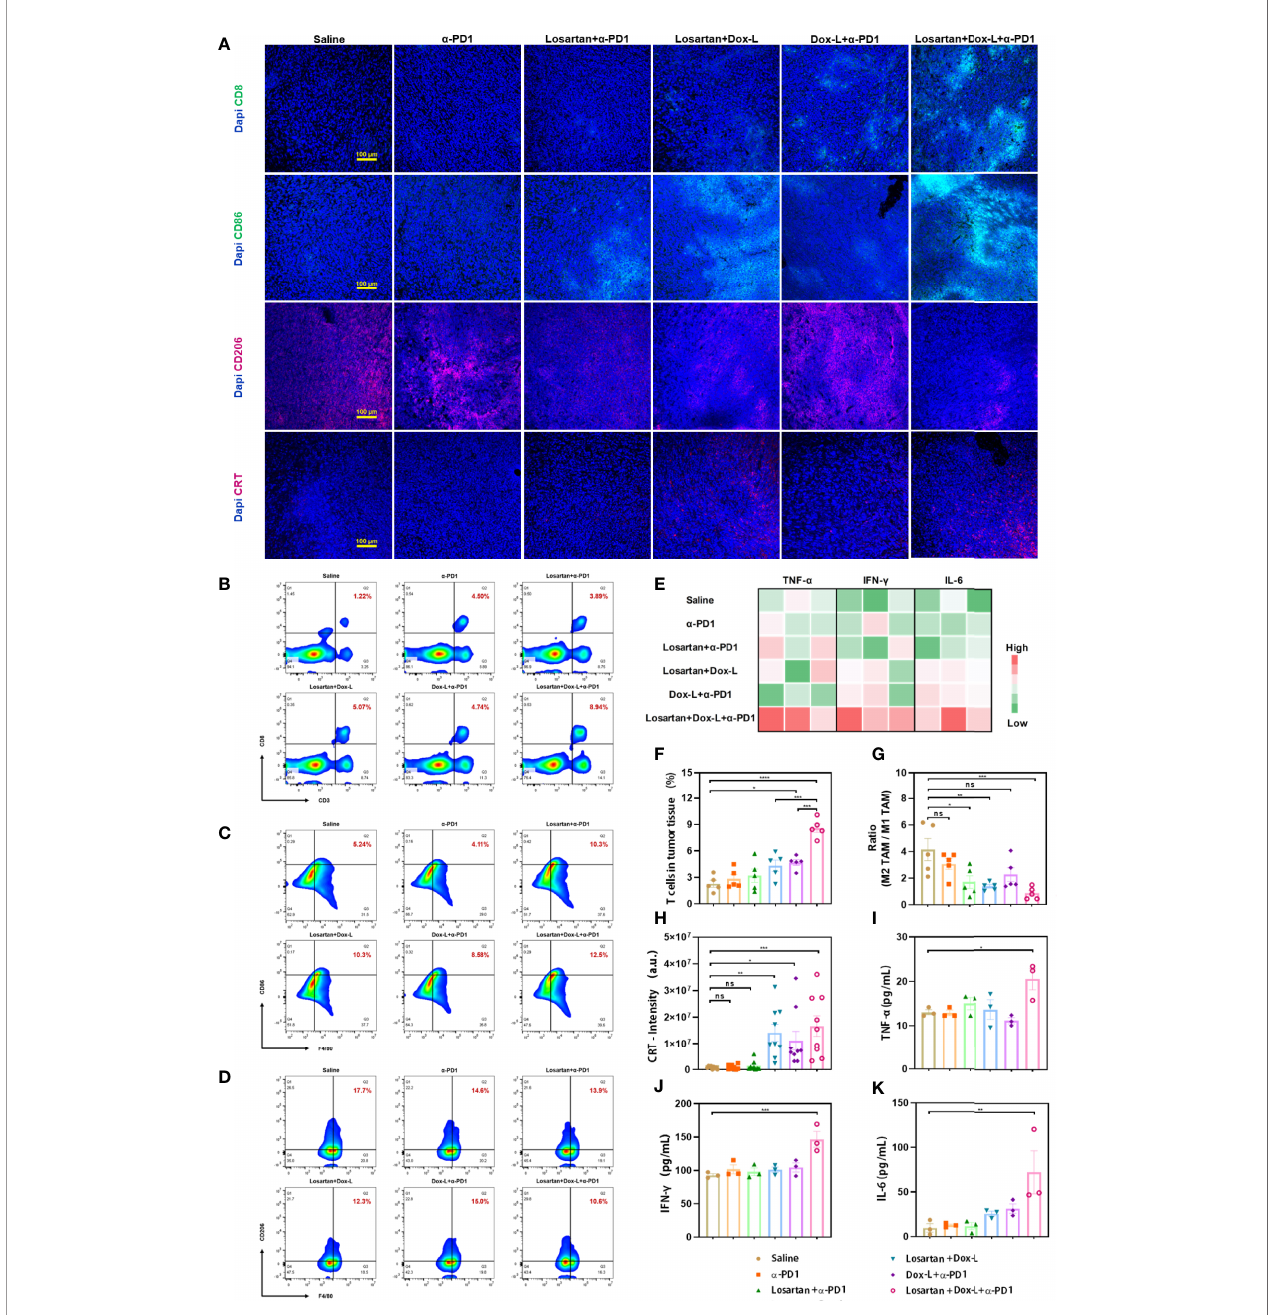
FIGURE 4 | Losartan combined with chemo-immunotherapy promotes immune-stimulation in orthotopic 4T1 breast tumors. (A) Representative fl uorescence images of 4T1 tumor slices immunostained for (effector T cell marker CD8, green), CD86 (M1-like TAM marker, green), CD206 (M2-like TAM marker, red), CRT (ICD effect marker, red) and DAPI (cell nuclei, blue). (B – D) Representative fl ow cytometry plots showing the tumor immune cells, including CD8+ T cells (CD45+, CD3+, CD8+), M1-like TAMs (CD11b+, F4/80+, CD86+) and M2-like TAMs (CD11b+, F4/80+, CD206+) in tumors after different treatments. (E) Heat map plot of ELISA results. (F) Quanti fi cation of the level of CD8+ T cells by fl ow cytometry analysis (n = 5). (G) Ratio of M2-like TAM to M1-like TAM by fl ow cytometry analysis (n = 5). (H) Quanti fi cation of CRT positive staining signals from the images shown in (A) (n = 9). Cytokine quanti fi cation of the secretion of TNF- a (I) , IFN- g (J) , IL-6 (K) in sera from mice after various treatments as indicated in the fi gure (n = 3). Scale bar = 100 m m. Data are expressed as the mean ± SEM. Statistical signi fi cances were calculated via one-way ANOVA, * p < 0.05, ** p < 0.01, *** p < 0.001 and **** p < 0.0001. ns, no signi fi